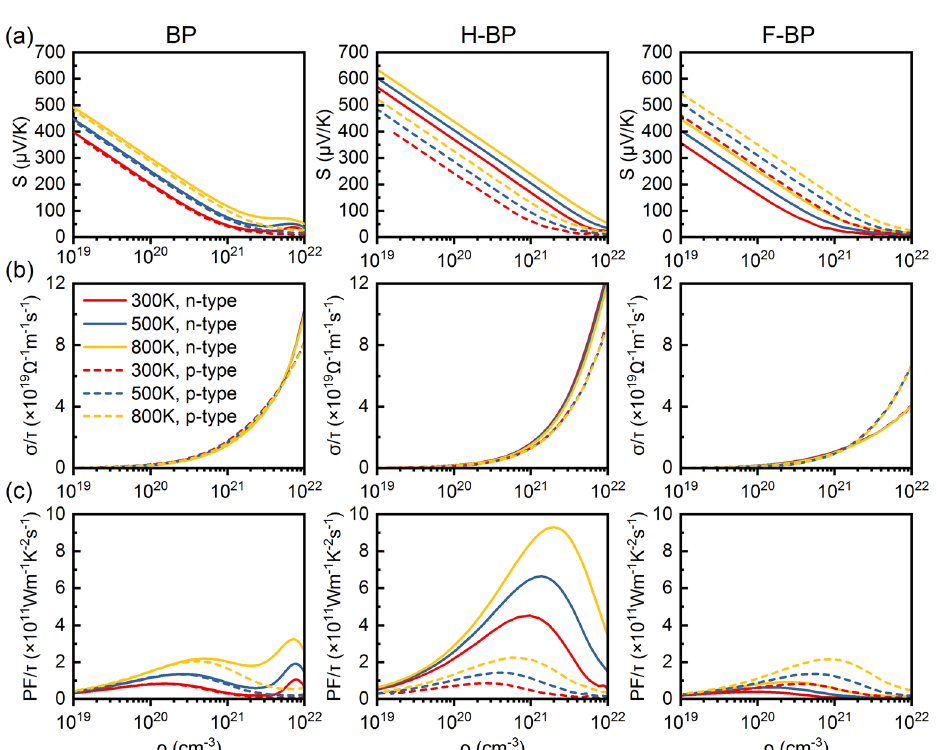
Figure 4. ( a ) The Seebeck coefficient S , ( b ) electronic conductivity σ/τ and ( c ) power factor PF/τ as a function of carrier concentration ρ for BP, H-BP and F-BP, respectively. The solid lines represent n -type doping and the dash lines represent p -type